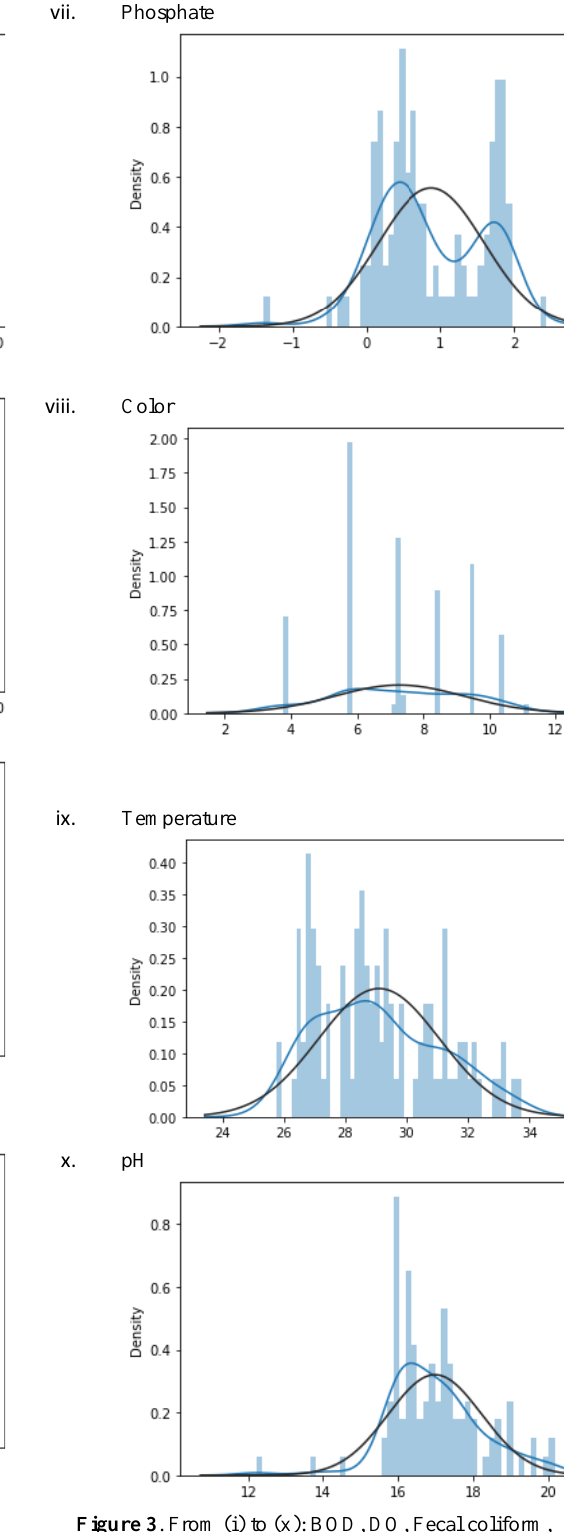
Figure 3 . From (i) to (x): BOD, DO, Fecal coliform, Chloride, TSS, Nitrate, Phosphate, Color, Temperature, pH: Shows the distplot The resulting positive and negative thresholds which limits the number of features from 14 to 16 is described in Figure 4 (a). The three WQ parameters with the lowest magnitude of Pearson Correlation threshold includes Fecal Coliform (0.31 &